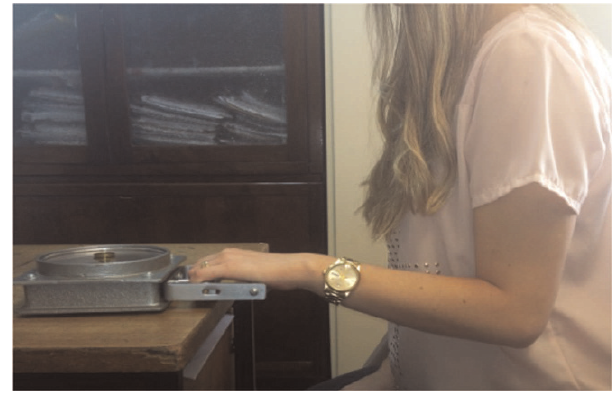
Figure 1 - Measuring tongue force with the Iowa Oral Performance Instrument. Figure 2 - Measuring grip strength using the Hand